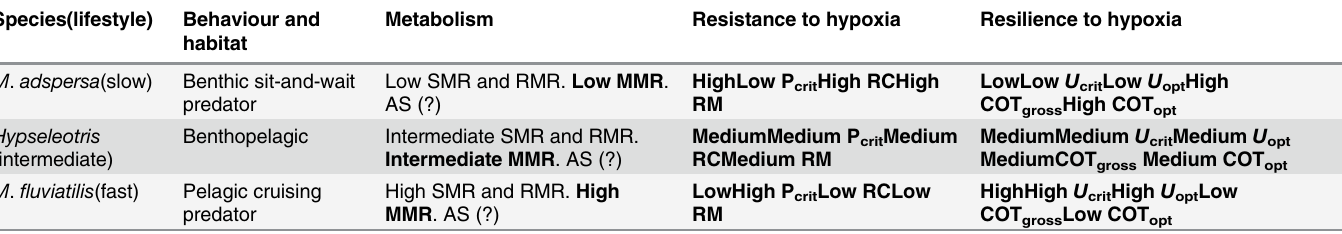
Table 1. Summary of the hypotheses tested (in bold) in this study, using three species of freshwater fish with differing lifestyles: Mogurnda adspersa , Hypseleotris sp., and Melanotaenia fluviatilis